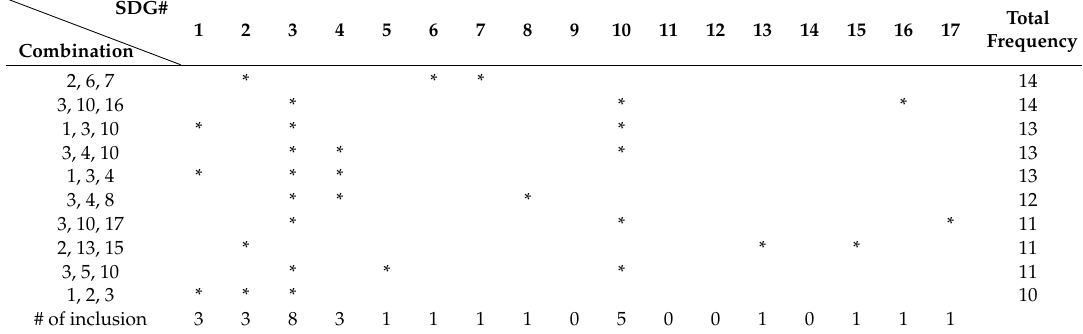
Table 4. The top most frequent list of SDG combinations with three SDGs co-linked in a paper. CombinationSDG#